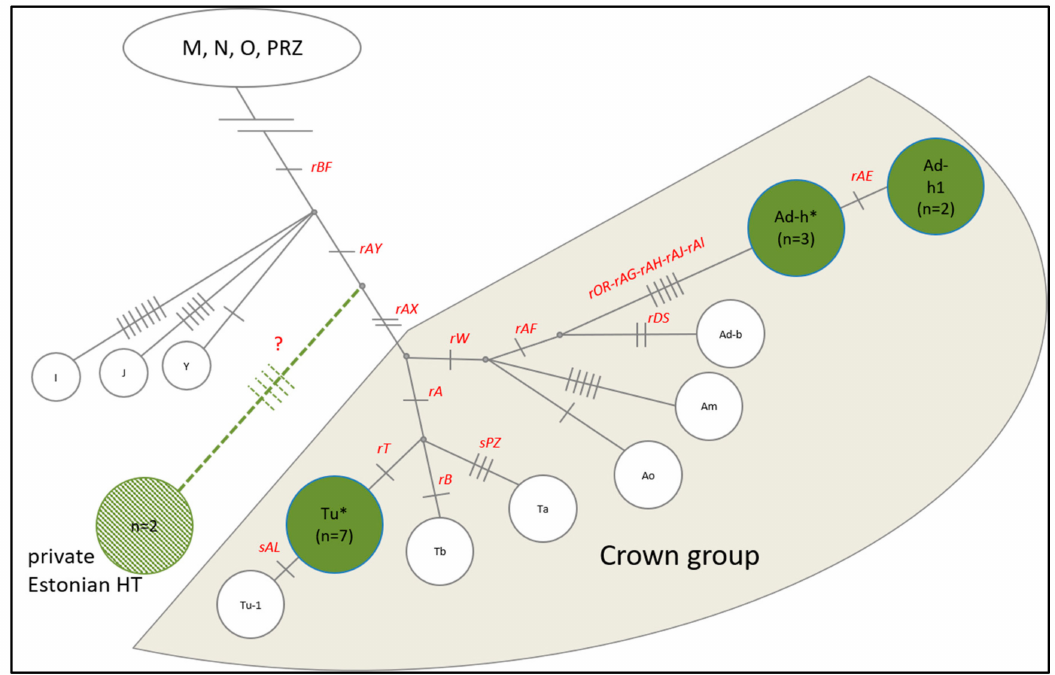
Figure 4. Horse Y chromosome haplogroups (HGs) based on 18 SNPs (in red font). Green circles represent the three identified HGs in the ENH; a novel HG outside the Crown group is shown in light